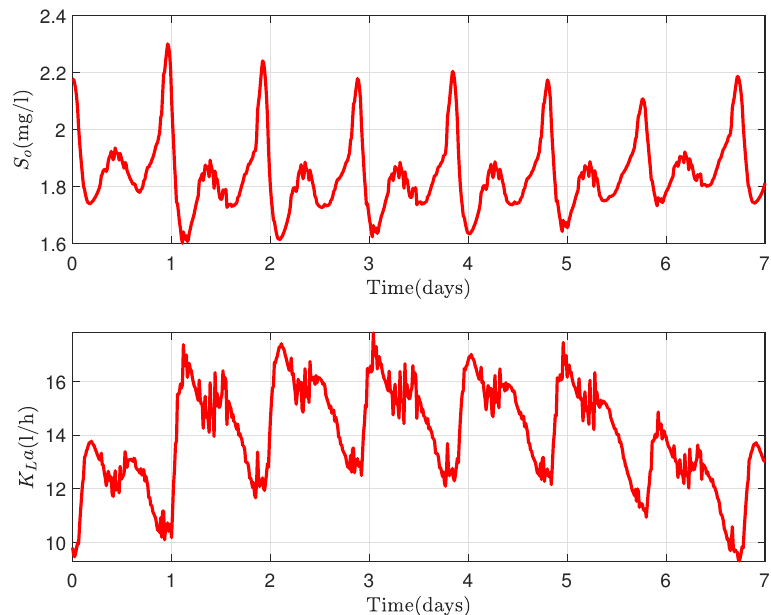
Figure 7. ( Above ): DO concentraton variation. ( Below ): Aeration flow for Scenario